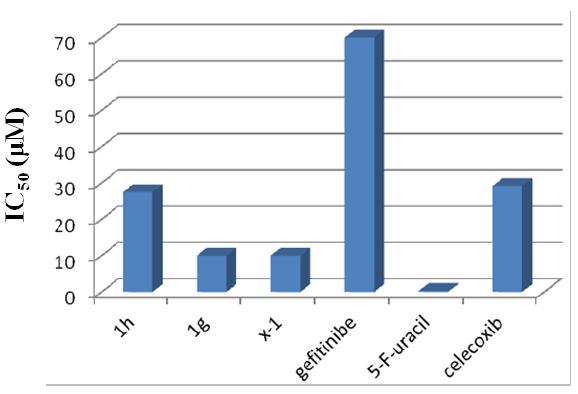
Figure 4. IC 50 values of the new synthesized compounds as well as gefitinib, 5-fluorouracil, and celecoxib. Table 9. % MCF-7 cell growth rates after cell exposure to the combinations of each novel compound 1h, 1g , and x-1 with gefitinib, 5-fluorouracil or celecoxib in their IC 50 or lower concentrations, for 48 h. Compound *